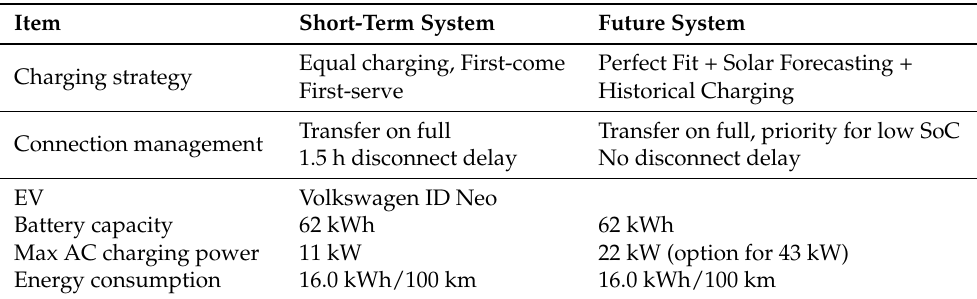
Table 1. Overview of the main characteristics of the short-term and future in-company smart charging